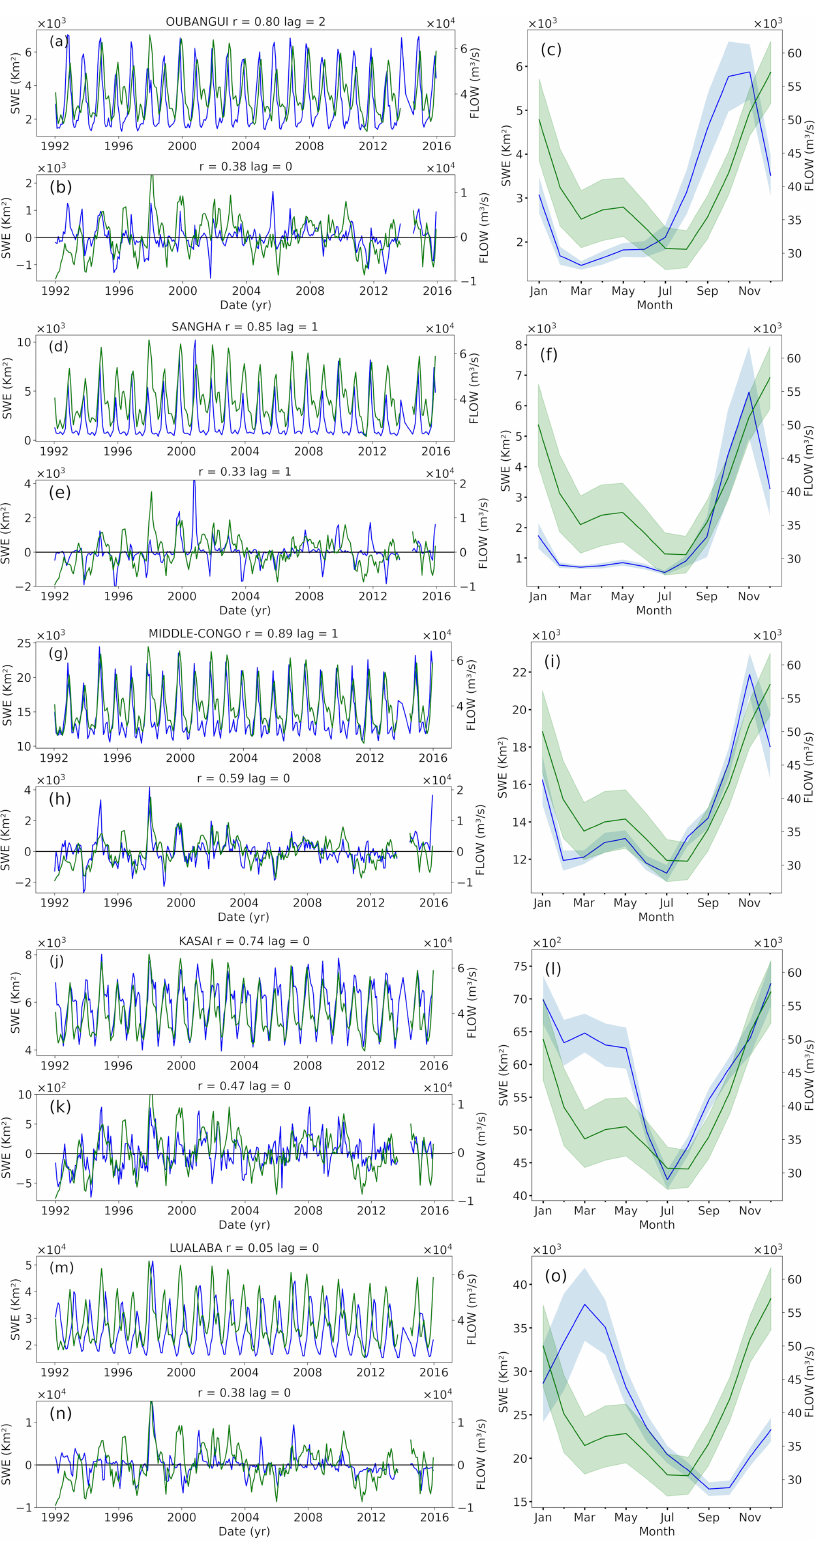
Figure 10. Similar to Figs. 7–9 but the SWE estimated at each of the five subbasins is compared against the in situ monthly mean water discharge at the Brazzaville/Kinshasa station. The blue line is for the SWE, and the green line is for the water flow at the Brazzaville/Kinshasa station. The annual cycle for each variable (1992–2015) is also displayed, with the shaded areas illustrating the standard deviations around the SWE and discharge